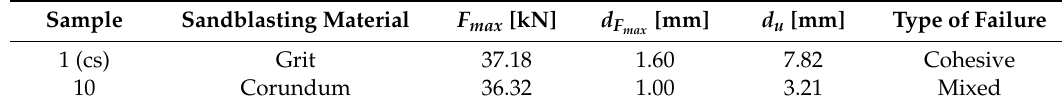
Table 3. Experimental results for samples 1 and 10.